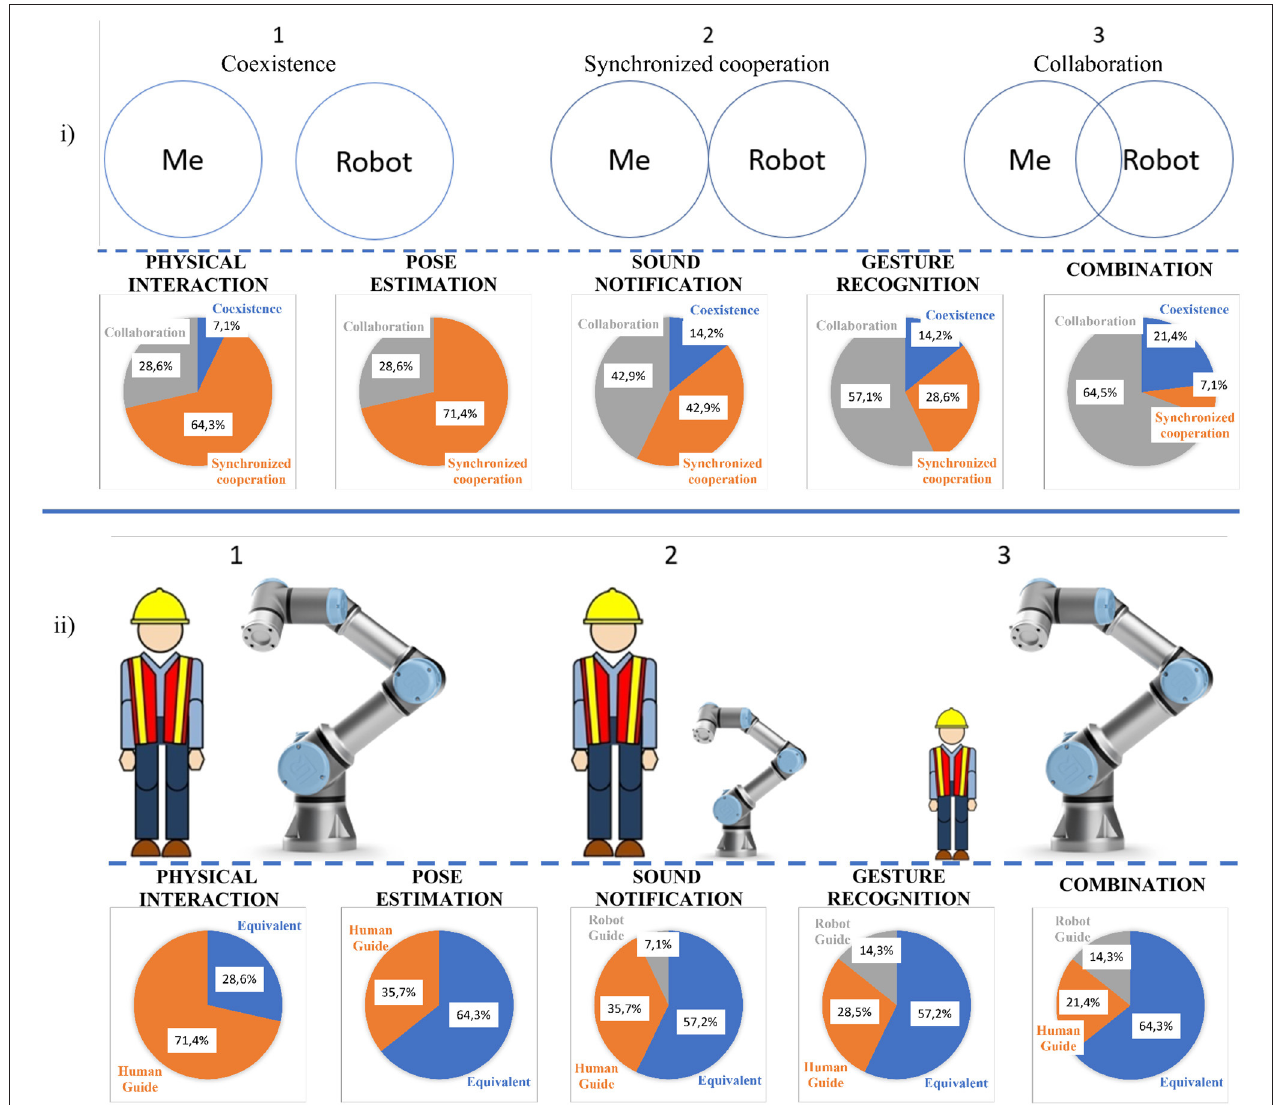
FIGURE 12 | (i) Categories of Human-Robot Interaction, (ii) Relationship between robot and human